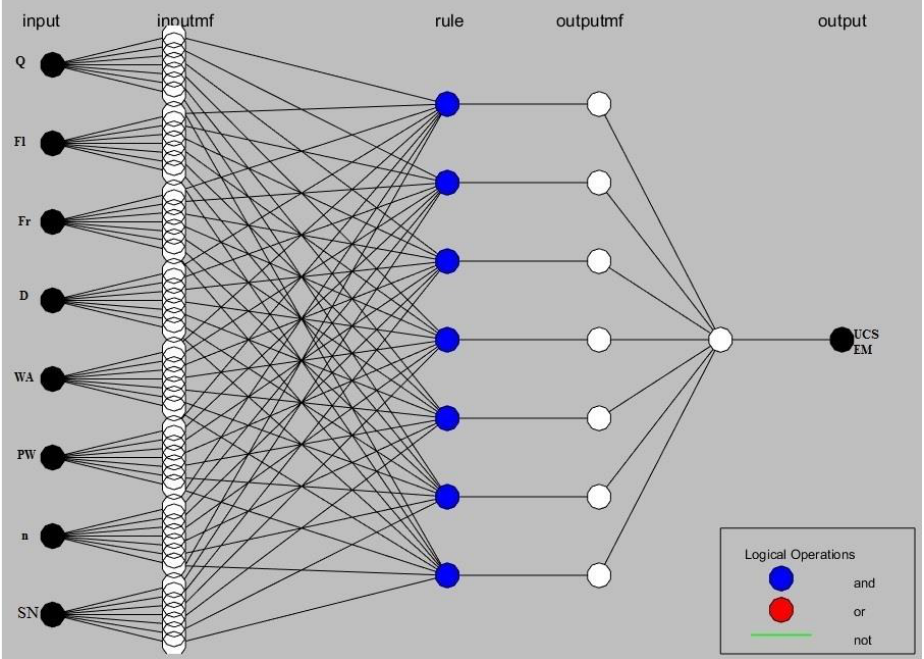
Figure 8. ANFIS model summary (black circles are inputs, white circles are outputs). Table 7. Used ANFIS model